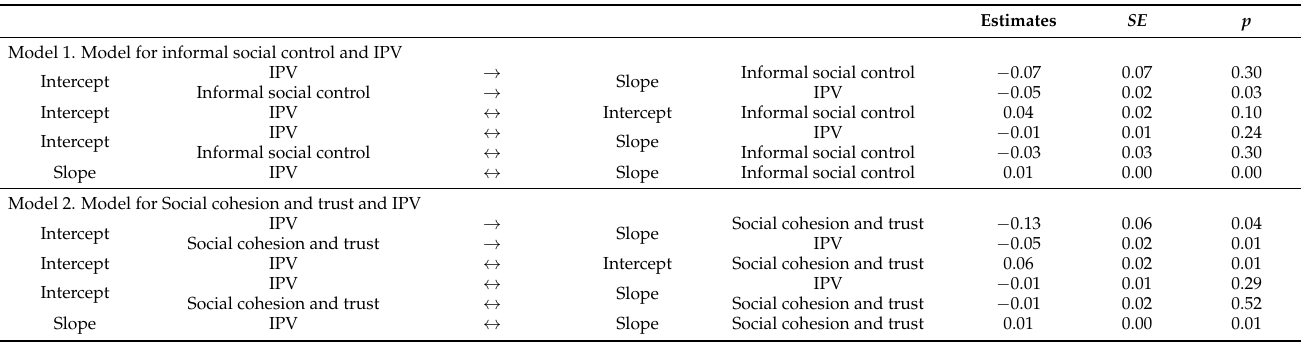
Figure 1. Parallel latent growth model. Note. CE = collective efficacy (i.e., informal social control or social cohesion and trust). Table 3. Parameter values of the parallel